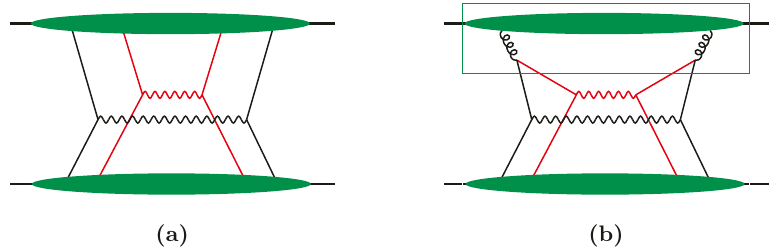
Figure 9. Counterparts to the 1v1 graph in figure 4a. In the 2v2 graph (a) there is no perturbative splitting, and in the 2v1 graph (b) one has a perturbative splitting in one of the two protons. The box encloses the DTMD of the upper proton and indicates that the splittings take place at transverse distances of order 1 /q T